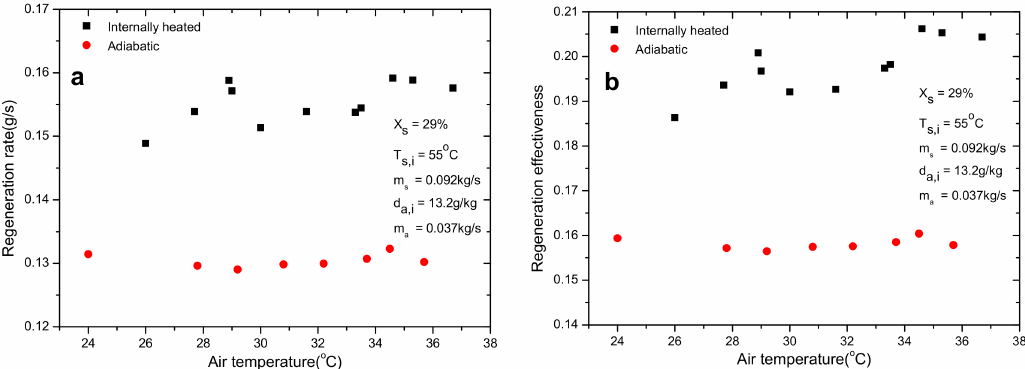
Figure 8. Effect of air inlet dry bulb temperature on regeneration performance: ( a ) regeneration rate; ( b ) regeneration